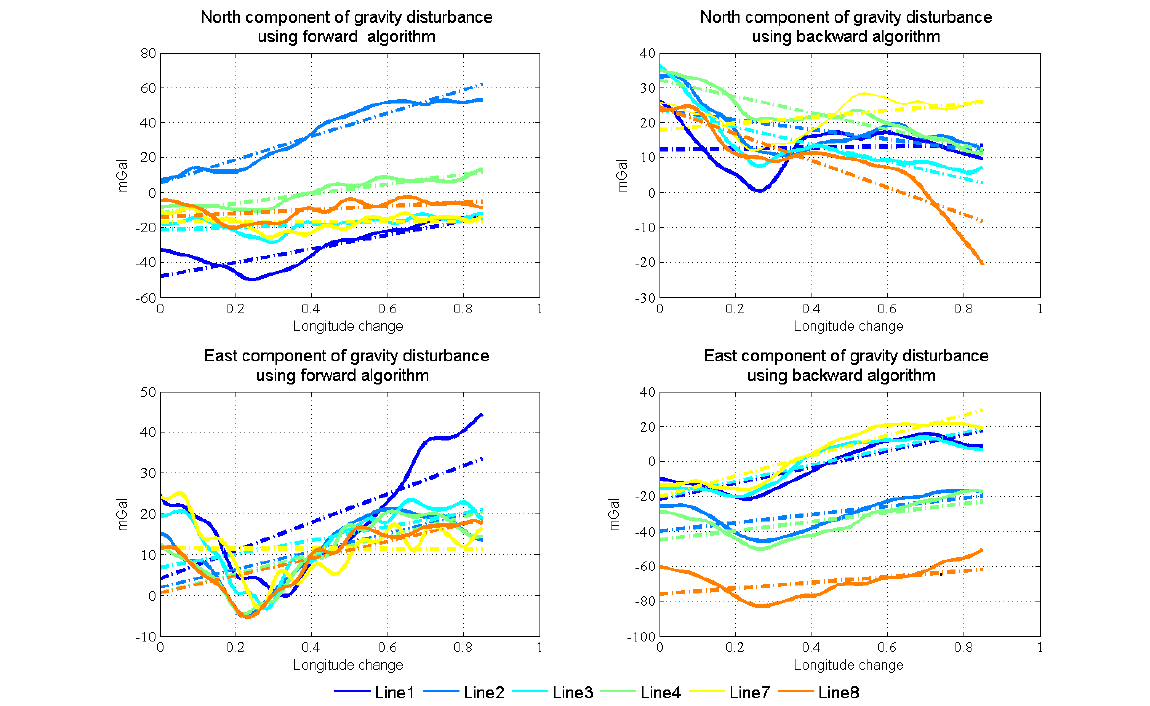
Figure 16. Two horizontal components’ linear fitting results in normal lines.